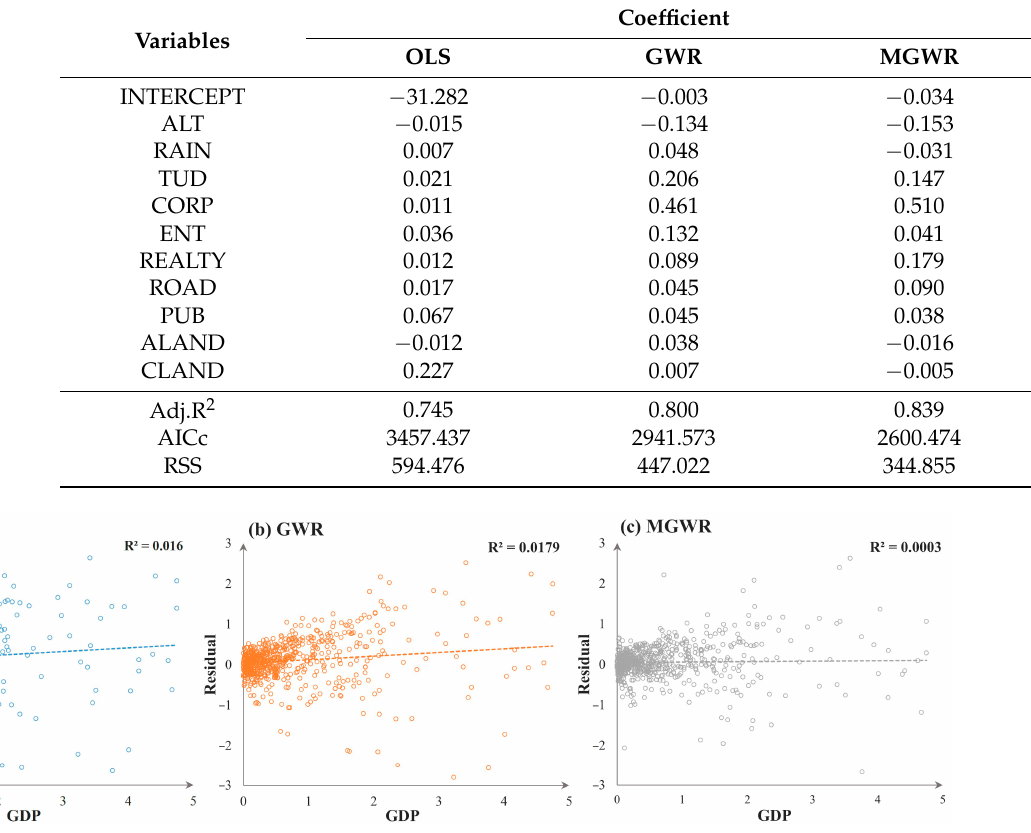
Figure 3. Scatter plot of three models’ residuals. ( a ) OLS; ( b ) GWR; ( c )